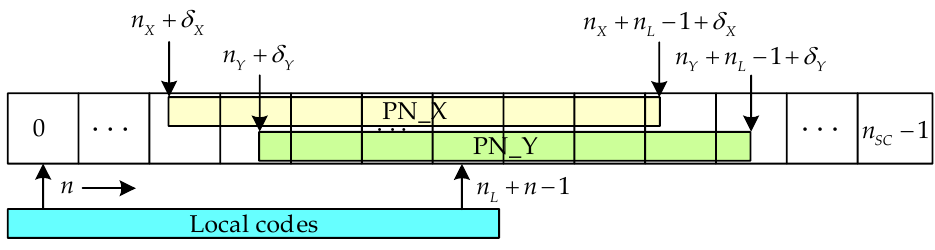
Figure 7. Flowchart of the proposed algorithm.